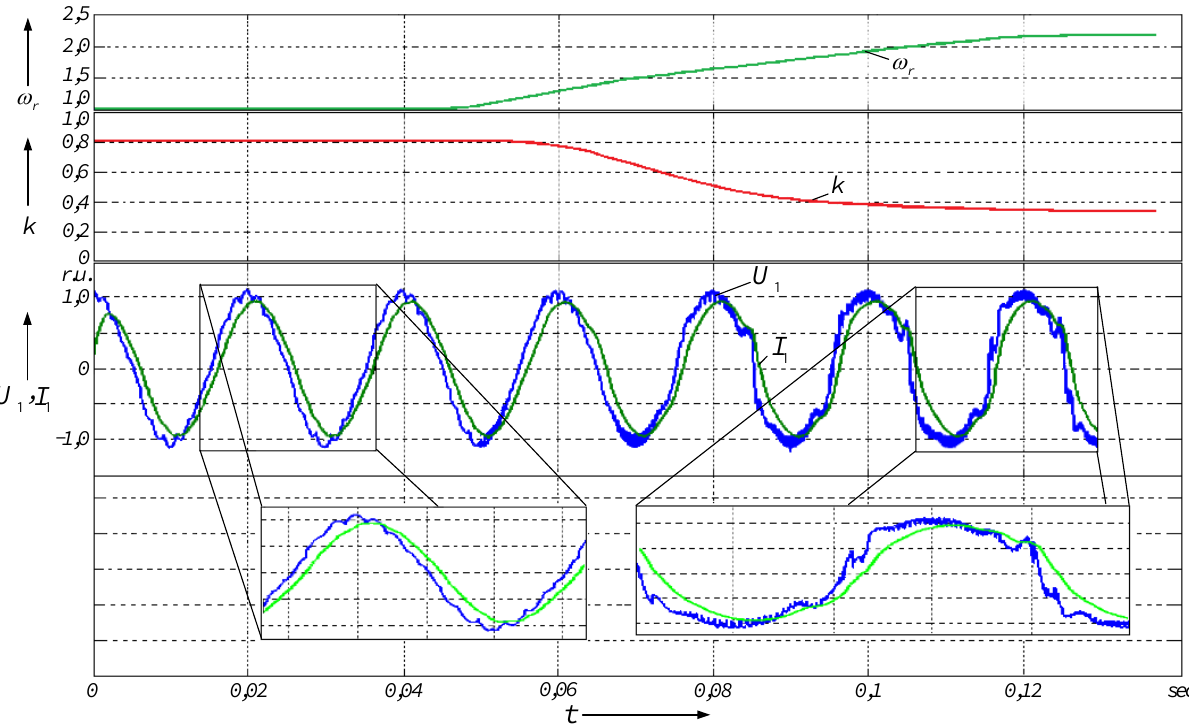
Figure 8. Load voltage and current waveforms of MCS when changing rotational speed of driving shaft while stabilizing output electrical parameters of MCS by means of DC excitation winding